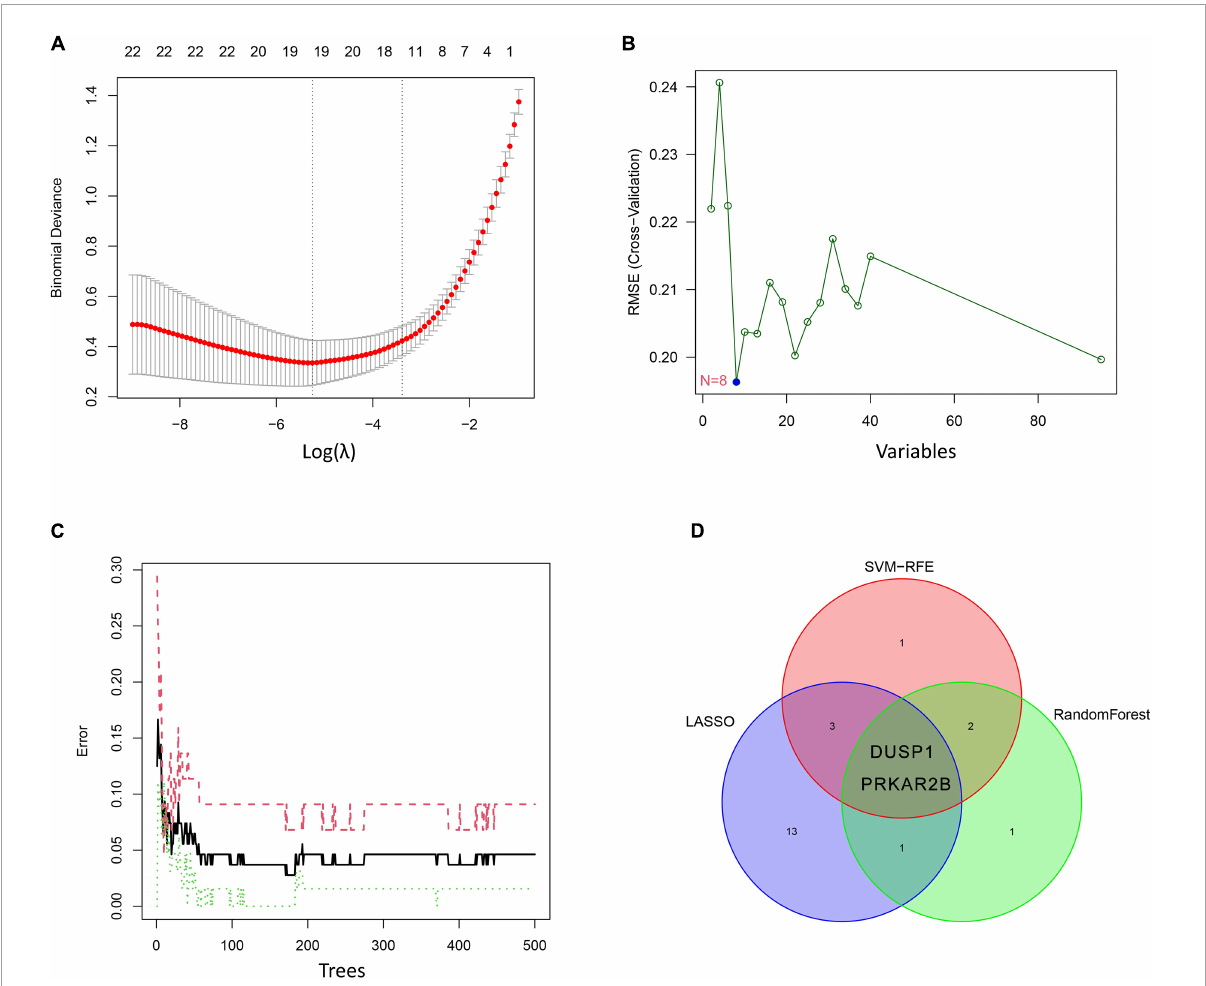
FIGURE4 Candidate diagnostic marker genes identified using the three algorithms. (A) Least absolute shrinkage and selection operator (LASSO) logistic regression algorithm. (B) Support vector machine-recursive feature elimination (SVM-RFE) algorithm. (C) Random forest (RF) algorithm. (D) Venn diagram showing the overlaps in the candidate diagnostic genes identified using the three